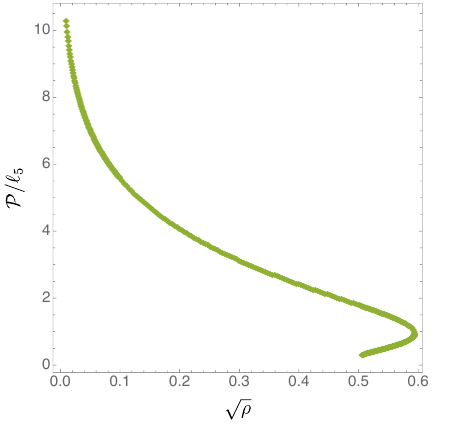
Figure 7 . Embedding diagram in the hyperbolic plane for a sample thin funnel with (left panel), and a sample fat funnel with in each panel indicates the embedding diagrams of the uniform funnels with the same value of (cid:26) .